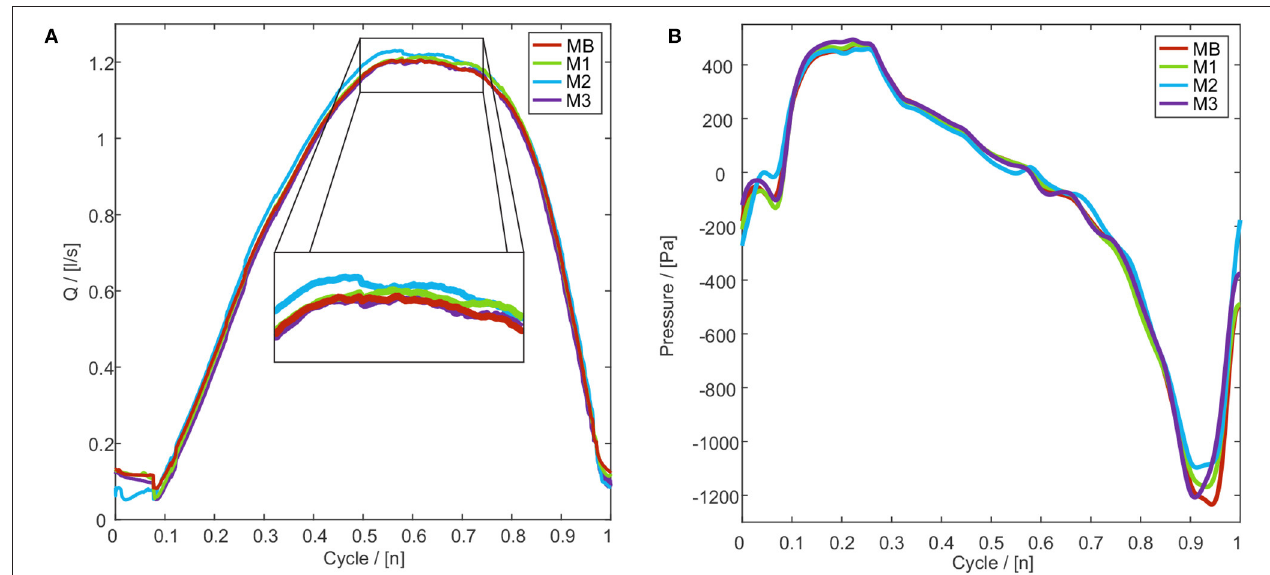
FIGURE 5 | (A) Volume flow rate through the glottis for one oscillation cycle for different mesh resolutions MB-M3. (B) Instantaneous pressure evolution for mesh resolutions MB-M3 for one oscillation cycle at point P1, see Figure 2 . The pressure evolutions were smoothed by a low-pass filter (Butterworth), with a cut-off frequency of 2,000Hz, to reduce the numerical